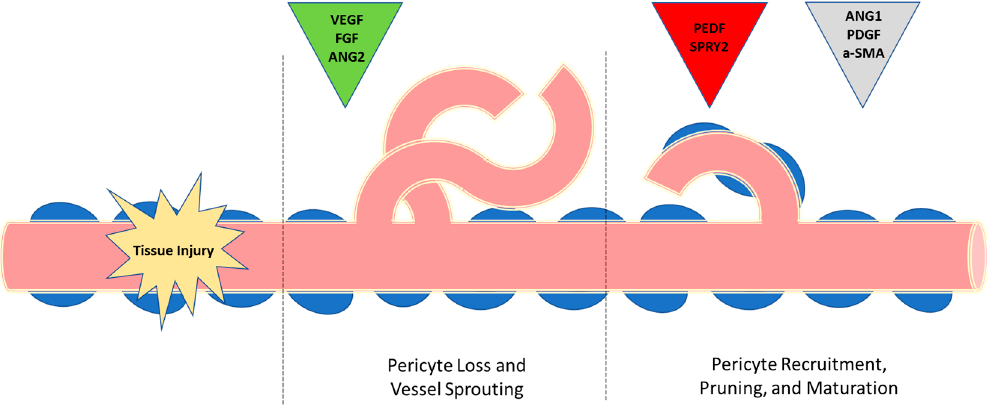
Figure 1. Events in wound angiogenesis. In the normal quiescent state, capillaries (pink) are surrounded by pericytes (blue). Following injury, the hypoxia that is created by the disruption of the vasculature stimulates the production of pro-angiogenic factors (green triangle), resulting in the sprouting of immature and disorganized new capillaries. In the remodeling phase, anti-angiogenic factors (red triangle) cause most of the newly formed capillaries to undergo apoptosis, and the capillary bed is pruned. Maturation factors (gray triangle) support the recruitment of stabilizing pericytes and the maturation of the basement membrane on the new capillaries. The result is a stable, well perfused capillary bed with a vessel density similar to normal uninjured tissue.